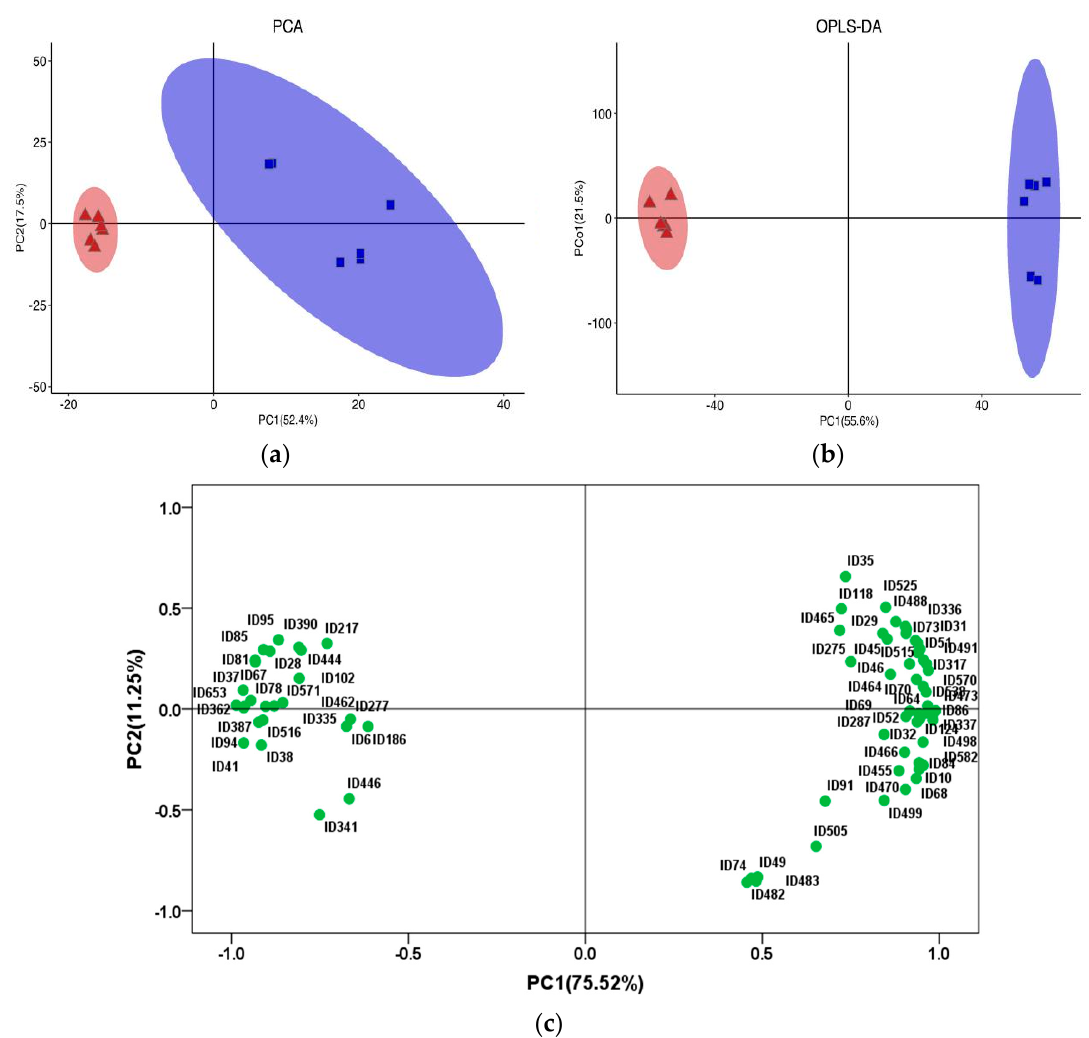
Figure 2. ( a ) The score plot of principal component analysis (PCA) of lipids in yak LD under graze feeding (GF) and stall feeding (SF). Red represents SF group; blue represents GF group. ( b ) The score plot of orthogonal partial least squares discriminant analysis (OPLS-DA) of lipids in yak LD under GF and SF. ( c ) Loading-PAC of significantly different lipids (SDLs) in the LD of GF and SF yaks. PC1 represents principal component 1, and PC2 represents principal component 2.